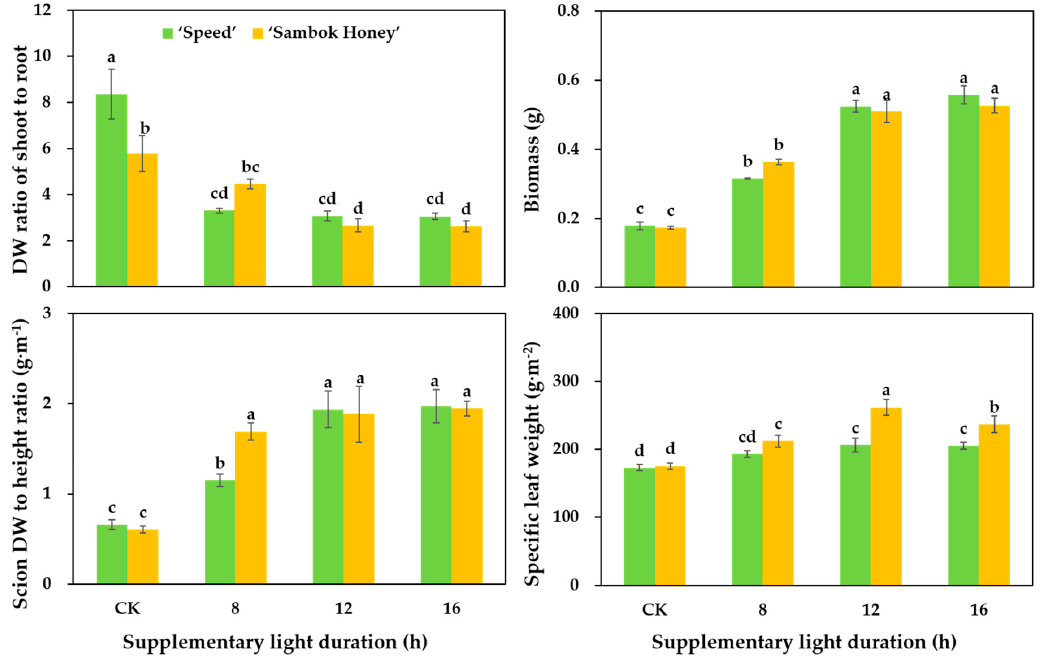
Figure 2. The effects of the supplementary light duration on the dry weight ratio of the shoot and root, biomass, dry weight to height ratio of the scion, and specific leaf weight of two cultivars of watermelon, ‘Speed’ and ‘Sambok Honey’, grafted onto ‘RS Dongjanggun’ bottle gourd rootstocks, after 10 days of supplementary light treatments. The error bars represent the SEs of the biological replicates ( n = 3). Mean separation within columns are significantly different according to Tukey’s multiple range test at p = 0.05.